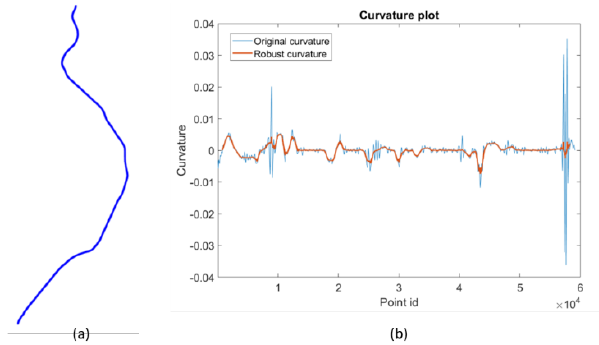
Figure 6. Centreline curvature. (a) A discrete number of points from the centreline is transformed to a Frenet trajectory path and seen as a continuous curve. (b) The curvature of the alignment is computed and refined using the robust approximation from Lin et al.